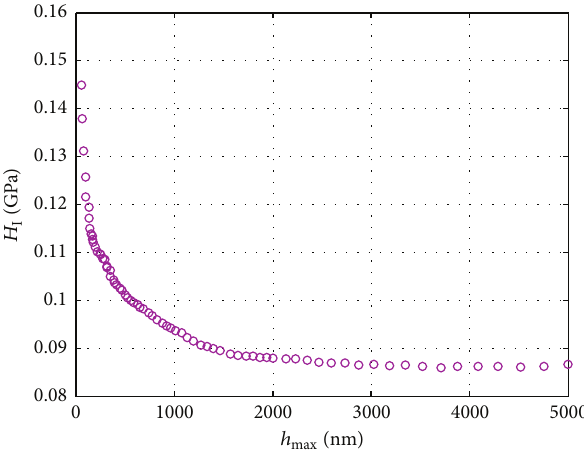
Figure 18: Indentation hardness of nylon 11 (PA11) obtained by a Berkovich tip and CSM method (a 0.05 s −1 strain rate is imposed during loading and unloading with a 60s holding time) [63].